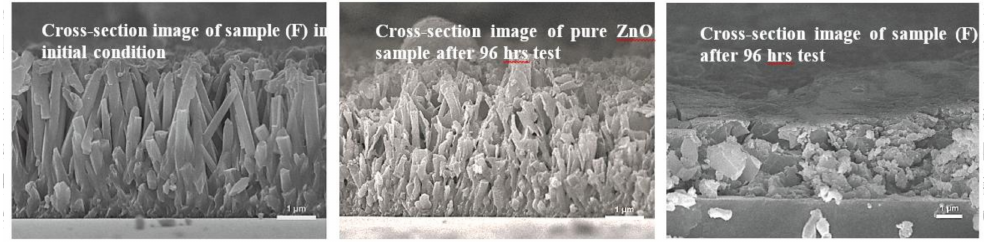
Figure 5. SEM images of pure ZnO sample and sample (F) before and after drug release testing,